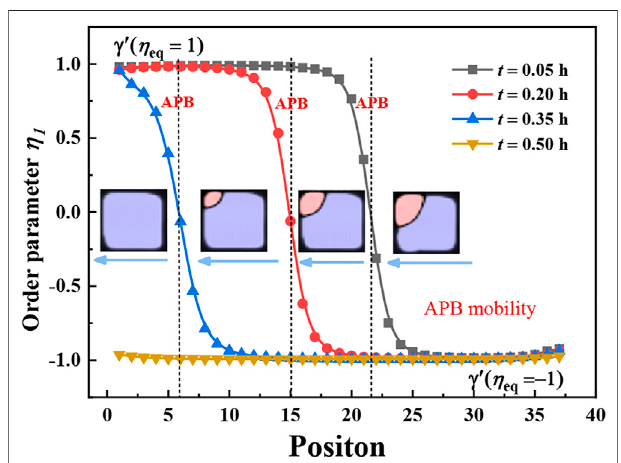
FIGURE 5 | Evolution of OPPs and order parameter η 1 through the APB at x * = 87 – 123, y * = 210 at 1173 K.